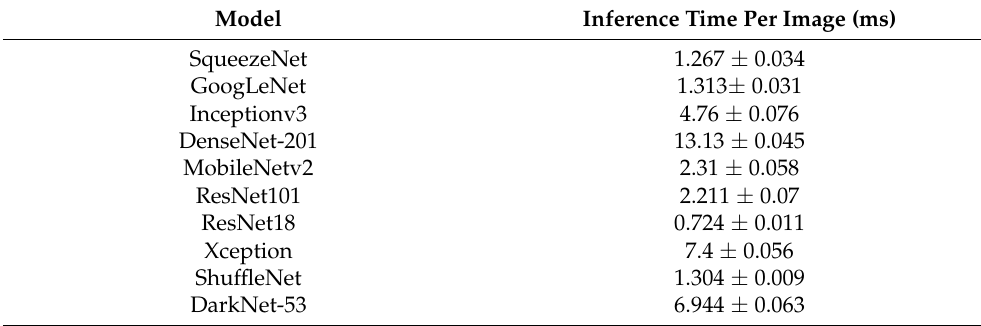
Table 6. The mean ± SD inference times per image for all algorithms. All times are in